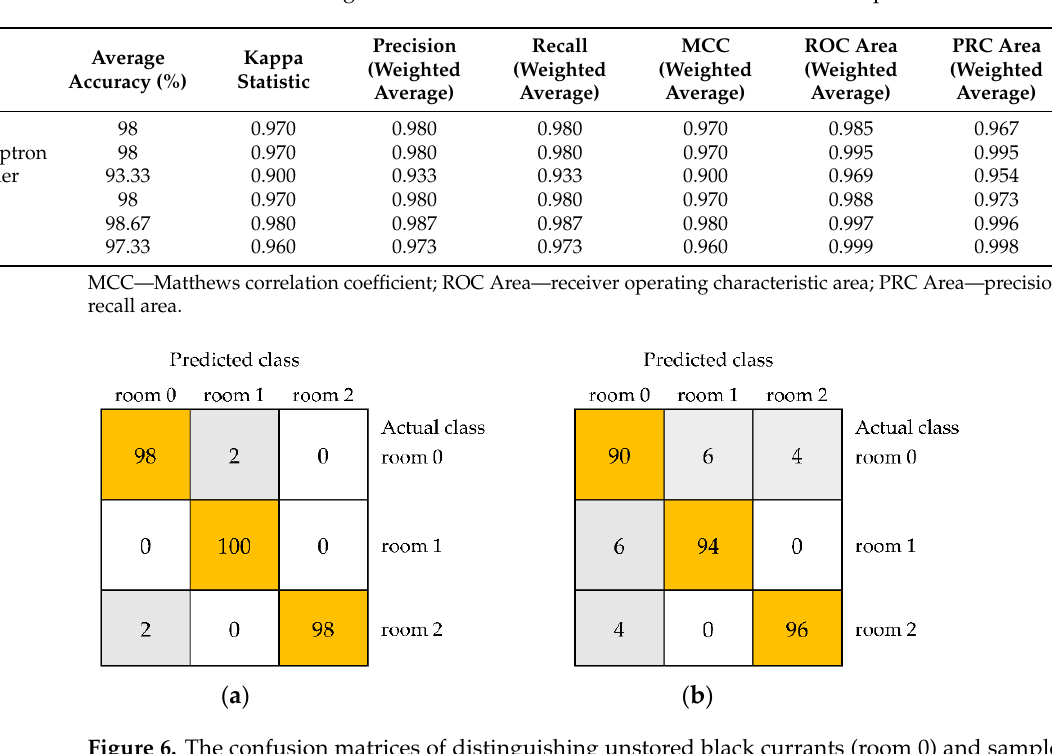
Table 5. The results of distinguishing unstored black currants and samples stored in the room for one week and two weeks using models built based on selected textures from color space XYZ.